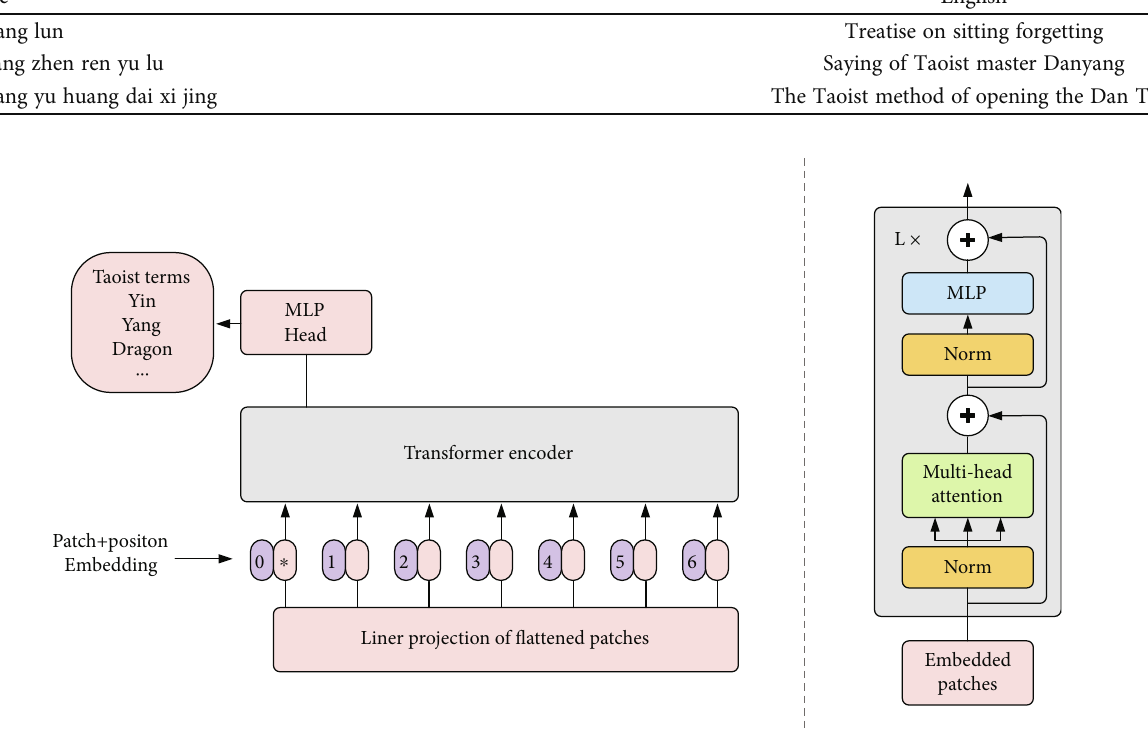
Figure 2: Model training